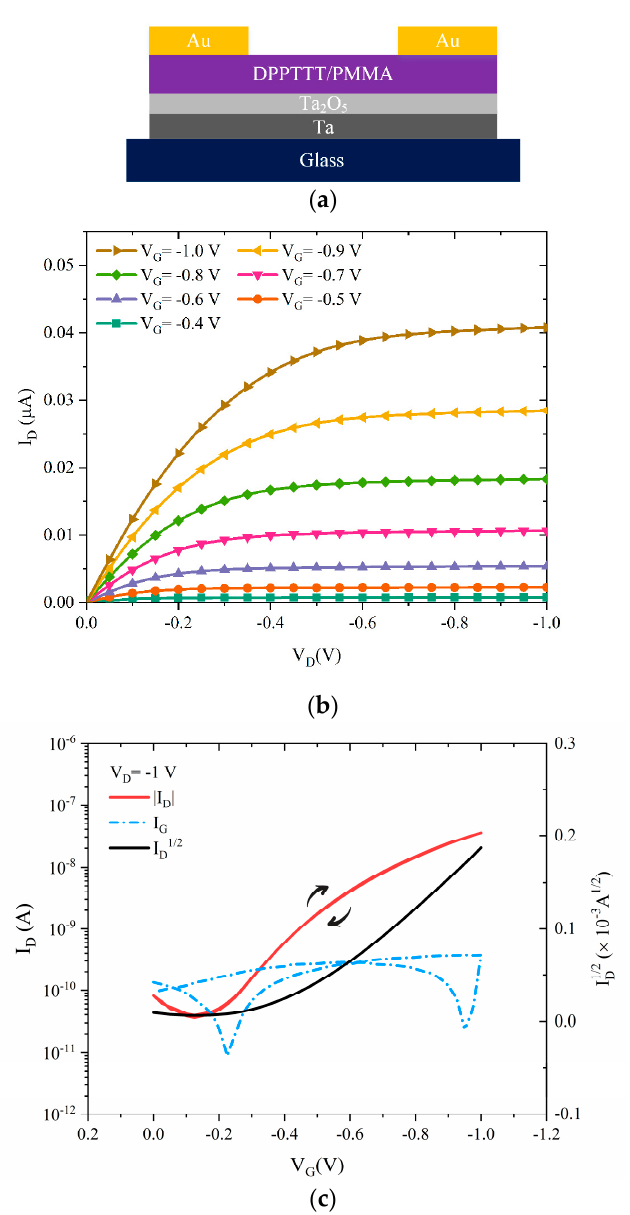
Figure 4. ( a ) Schematic structure of the OTFTs using bare Ta 2 O 5 anodized at V A = 20 V. ( b ) Output, and ( c ) transfer characteristics of the studied OTFTs including I D1 / 2 and I G vs. V G at V D = − 1,